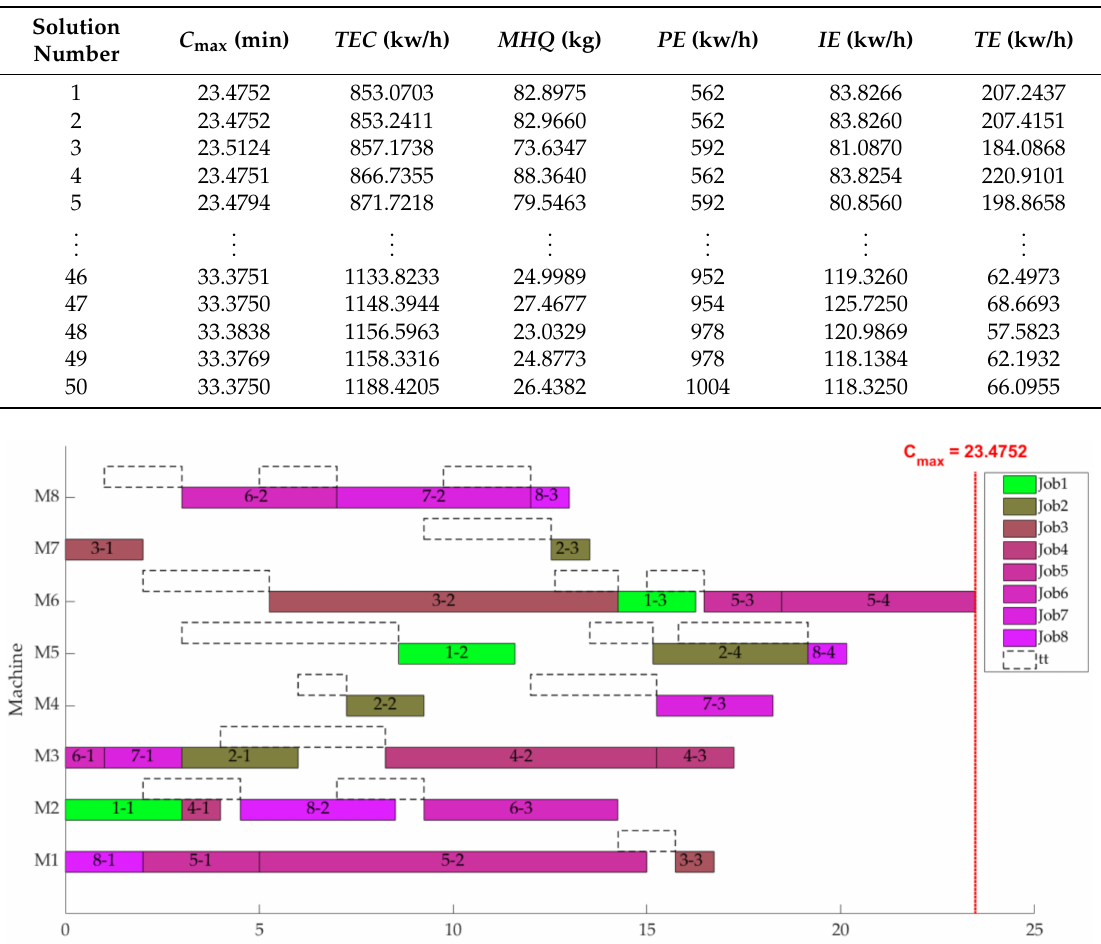
Figure 13. The Pareto solutions’ distribution for three objective functions. Table 5. The Pareto set.